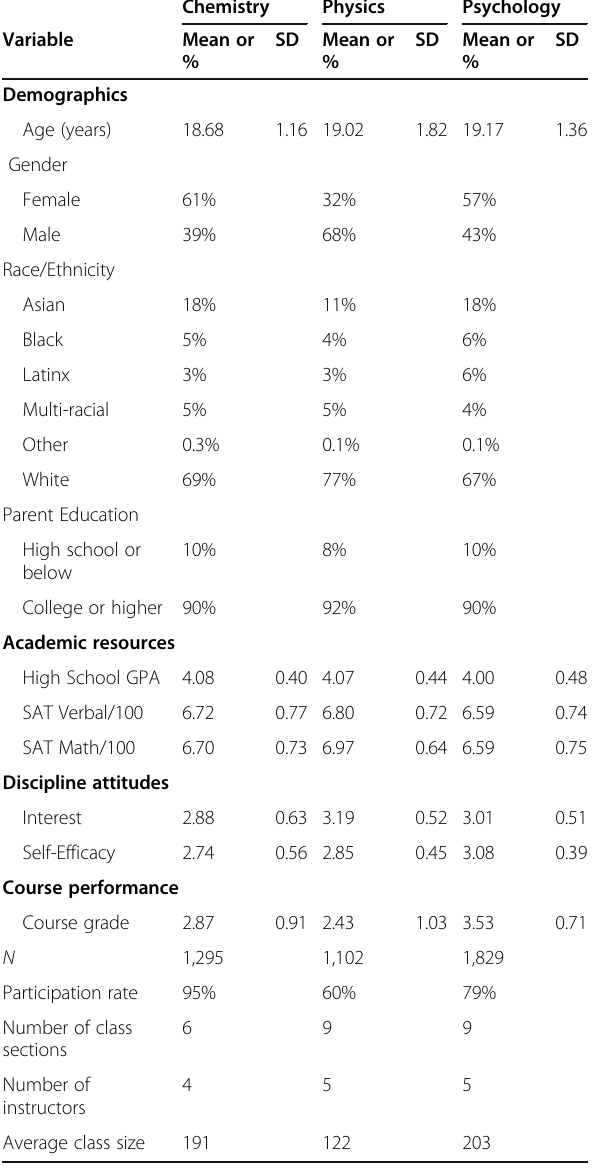
Table 1 Sample characterization in terms of demographics, academic resources, discipline-specific attitudes, and